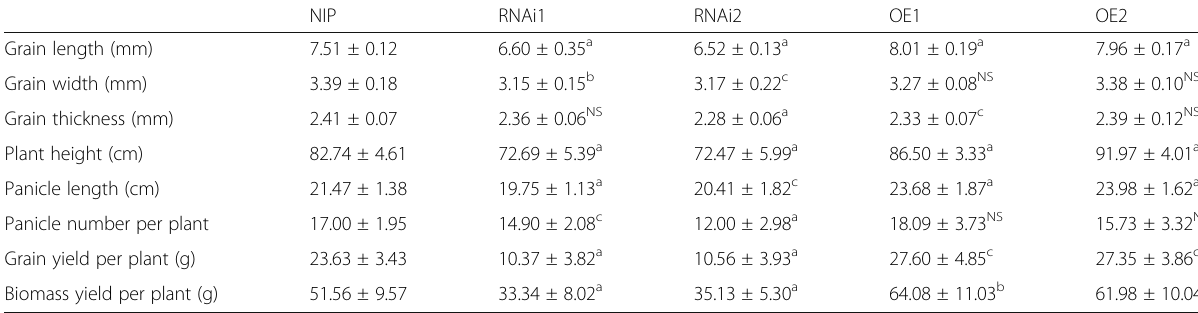
Table 1 Comparison of agronomic traits between NIP and the transgenic lines